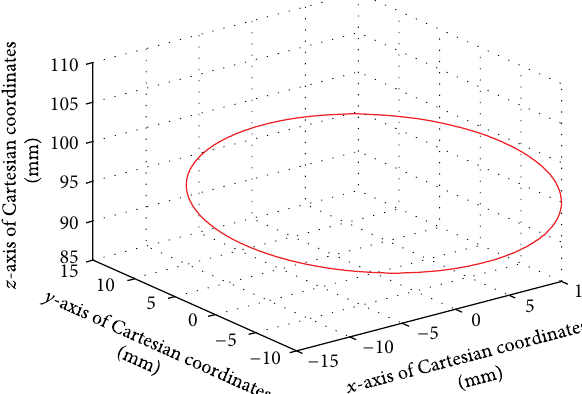
Figure 9: Rigid-body model build in Visual Nastran 4D.